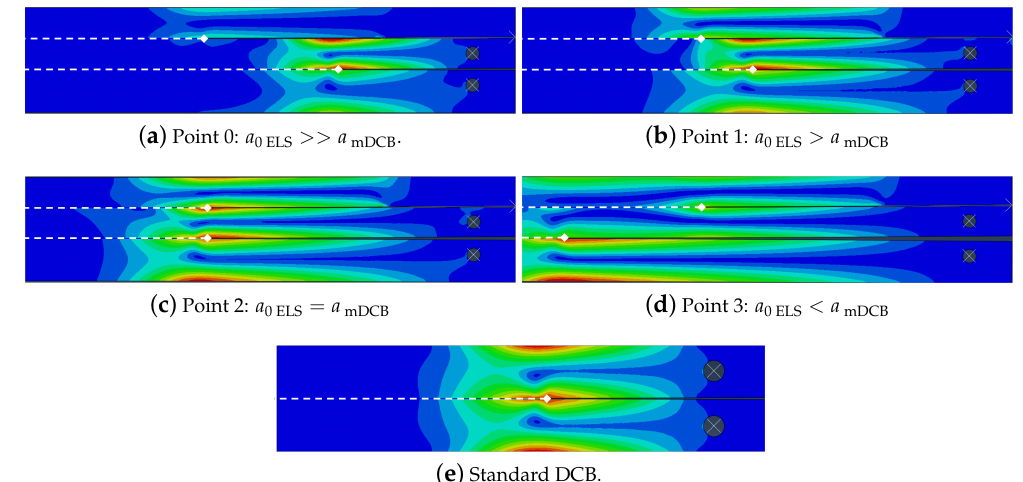
Figure 20. Stress distributions associated with the variation of a 0 ELS and a 0 mDCB configurations, plus the standard DCB stress distribution for reference. The dashed white line easily identifies each adhesive layer, as well as the evolution of the crack tips.